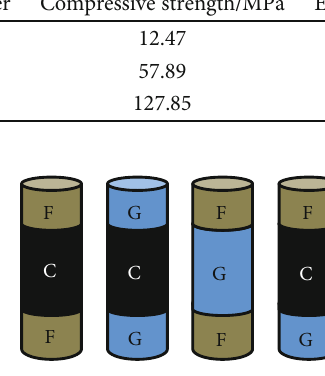
Figure 10: The combined body model schematic